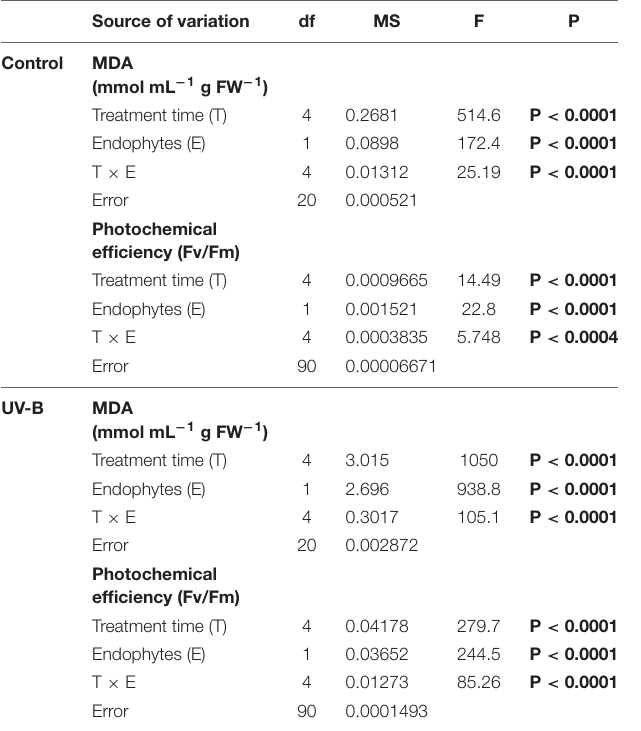
TABLE 2 | Results of factorial two-ways ANOVA evaluating the interactive effects of endophytes presence (E) and different times of treatment for (control: without